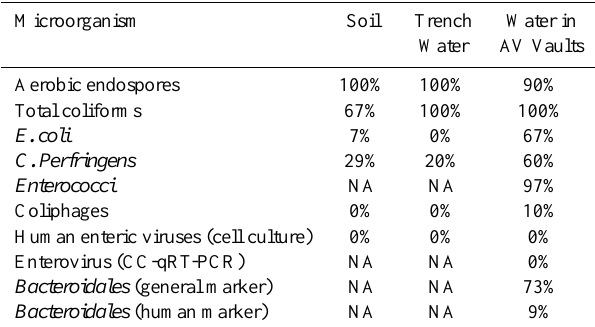
Table 1. Percentage of positive samples collected from potential contamination